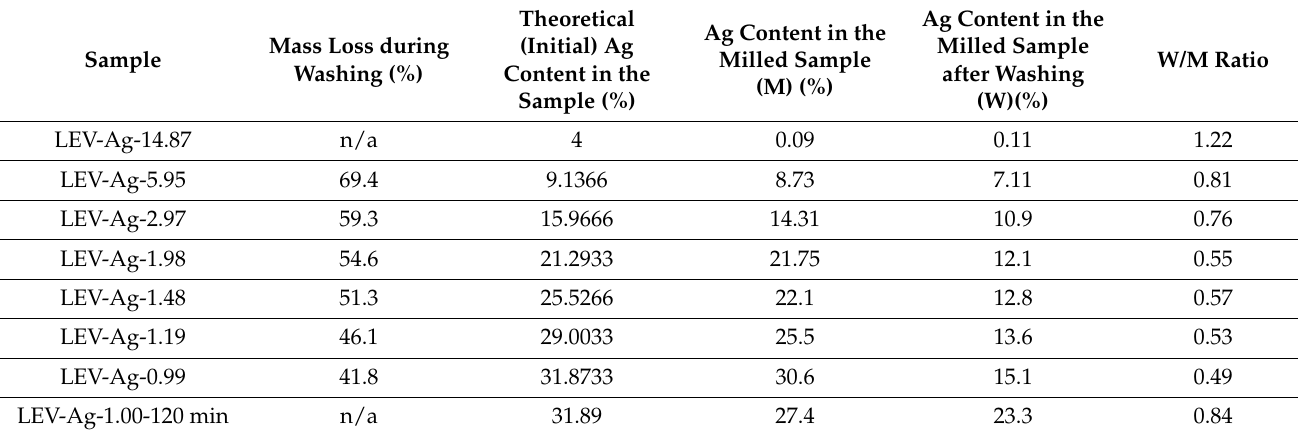
Table 2. Mass losses during washing, Ag content in the milled (M) and washed (W) samples determined by atomic absorption spectrometry and the corresponding W/M ratio. Ag Content in the Theoretical Ag Content in the Milled Sample (Initial) Ag Mass Loss during W/M Ratio Milled Sample Sample after Washing Content in the Washing (%) (M) (%) (W)(%) Sample (%) LEV-Ag-14.87